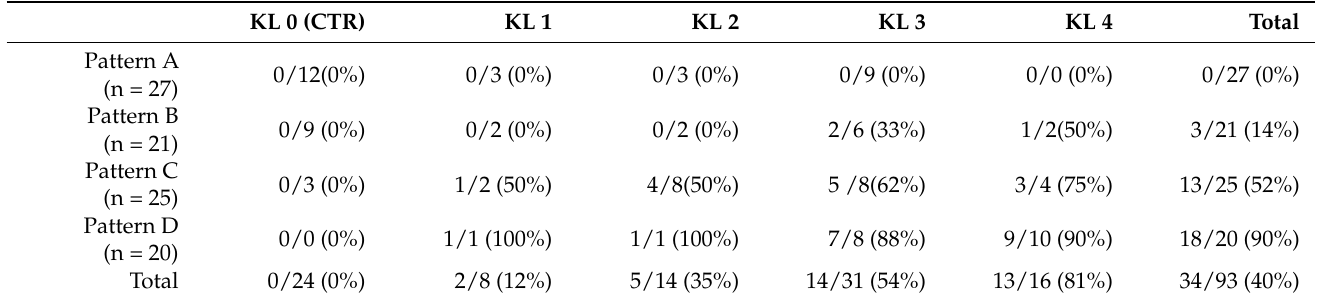
Table 3. Proportion of knees with clearly visible varus thrust stratified by KL grade and IMU classification.